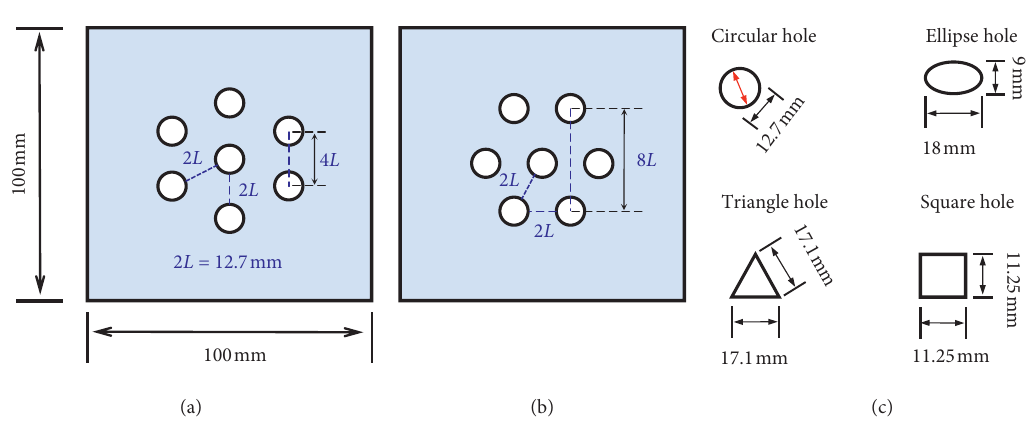
Figure 4: Macropore orientations. (a) Vertical orientation. (b) Horizontal orientation. (c) Hole